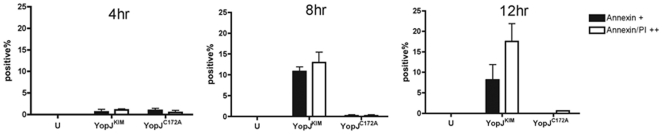
KIM5-infected macrophages have necrotic morphology as shown by Annexin V staining and PI uptake assay.BMDMs were seeded on glass coverslips in a 24-well plate and infected with Y. pestis strains expressing YopJKIM or YopJC172A or left uninfected (U). Annexin V staining and PI uptake assay was performed at 4 hr, 8 hr or 12 hr post-infection. Representative images were captured by digital photomicroscopy. Average percentages of Annexin V positive or Annexin V/PI double positive cells as counted from three random fields in three independent experiments are shown. Error bars represent standard deviations. Difference in values of single or double positive cells were not significant as determined by one way ANOVA.